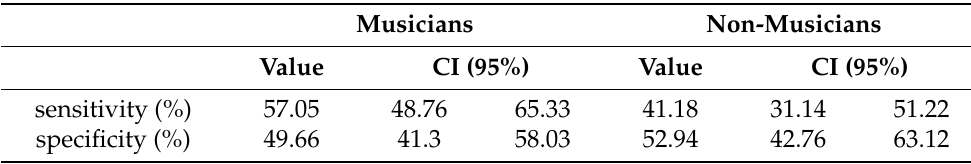
Table 9. Sensitivity and specificity in the human-computer